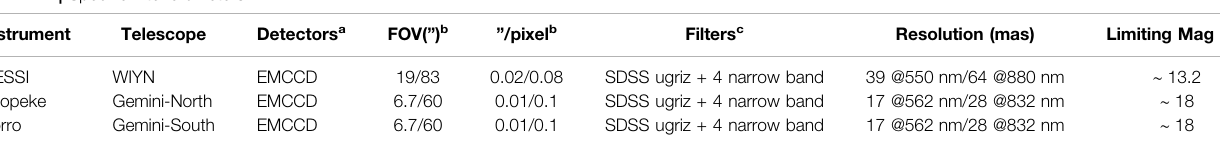
TABLE 1 | Speckle